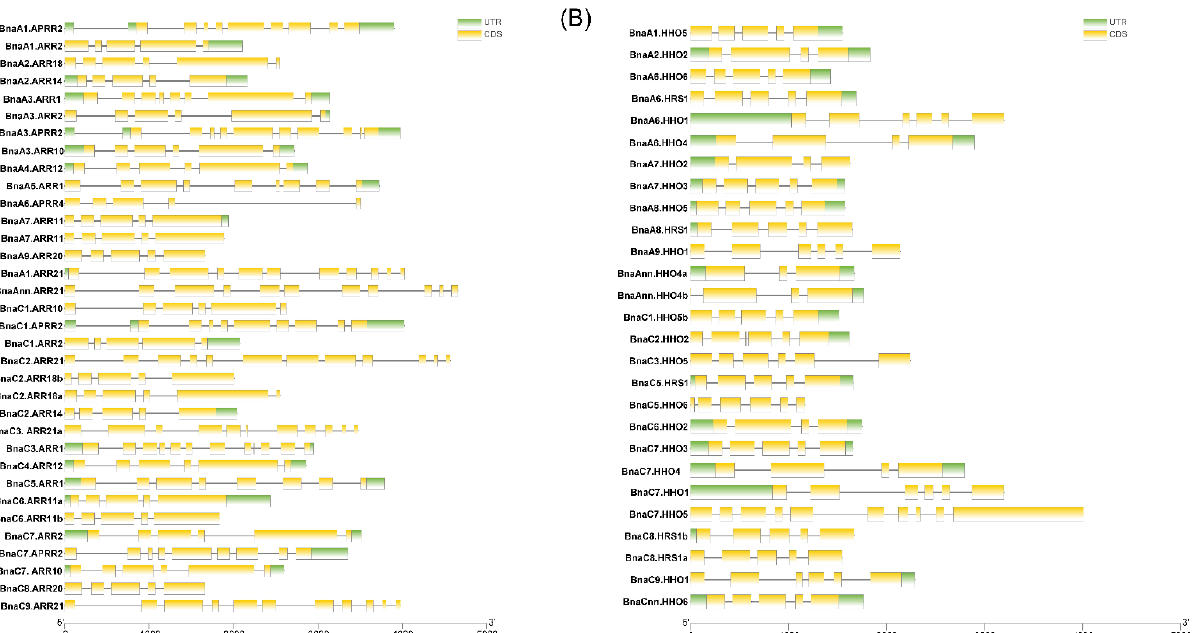
BnaA3.ARR10, and BnaA3.ARR2 on the A3 chromosome.